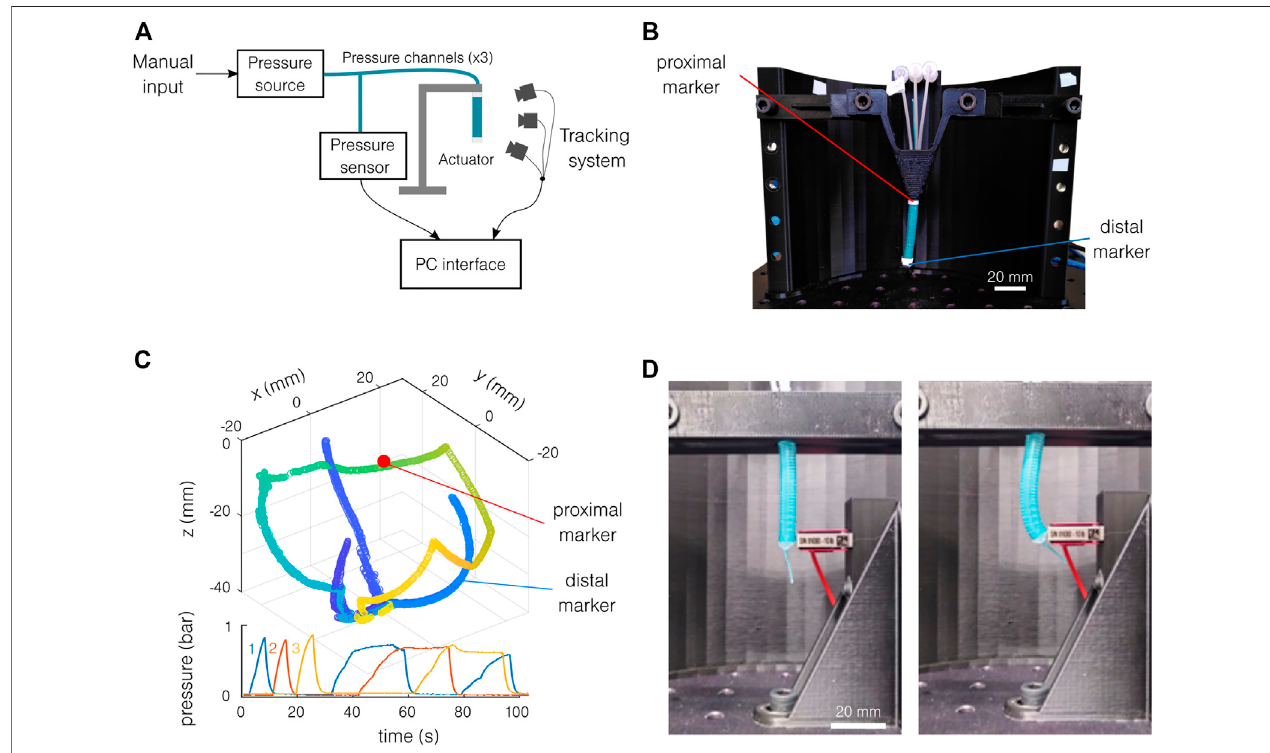
FIGURE 4 | Experimental setup. (A) Schematics of the motion tracking setup. (B) The actuator is placed vertically, and the position of the two markers is tracked. (C) Typical motion tracking results with the corresponding pressure pattern. The color in the spatial representation indicates the time. The three colors on the pressure graph indicate the different channels. (D) Setup for blocking force measurement, at rest (left), and actuated